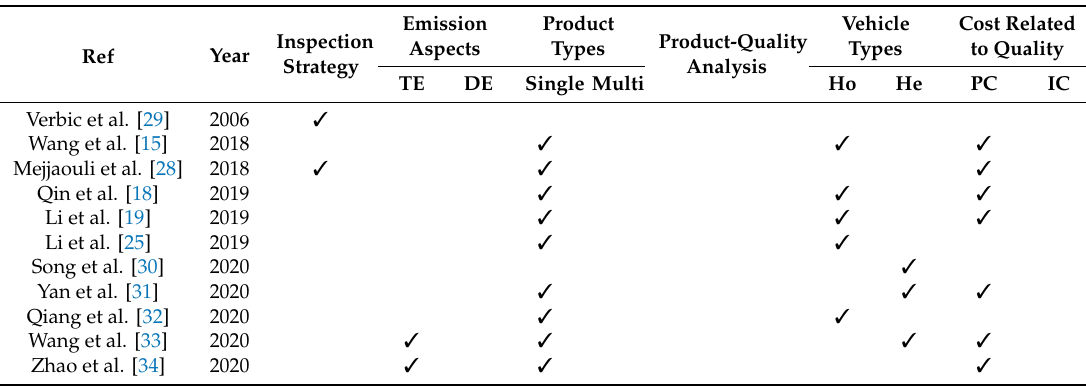
Table 1. The summary of cold-chain